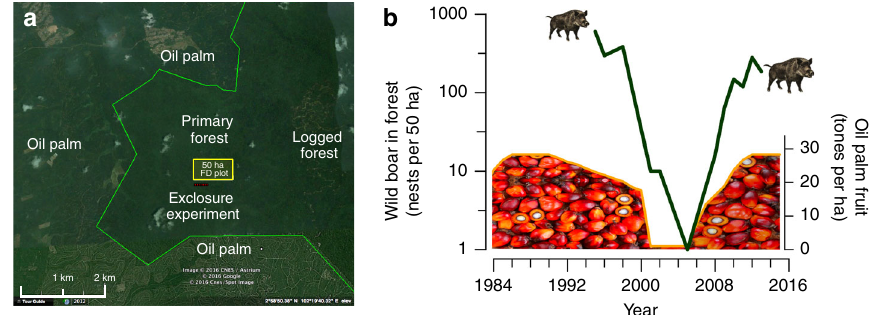
Fig. 2 Oil palm fruit in plantations drives wild boar irruptions in forests. a Pasoh Research Forest and surrounding oil palm plantations (Imagery from Google Earth). All immediately surrounding land use is oil palm plantations, except logged production forest to the east. The forest-plantation edge is outlined in green. Wild boar nest density was monitored in the 50-ha forest dynamics (FD) plot, outlined in yellow (length: 1 km east-west, width: 500 m north-south). The exclosure experiment is shown in red and located 25 m south of the FD plot along the southern plot border. b Green line illustrates the number of wild boar nests (left axis) in the Pasoh Research Forest 50-ha FDP as a function of fruit production in oil palm plantations located > 1.3 km away. Oil palm plantations were cut down in 2001, replanted in 2003 – 2004, and began fruiting again in 2006